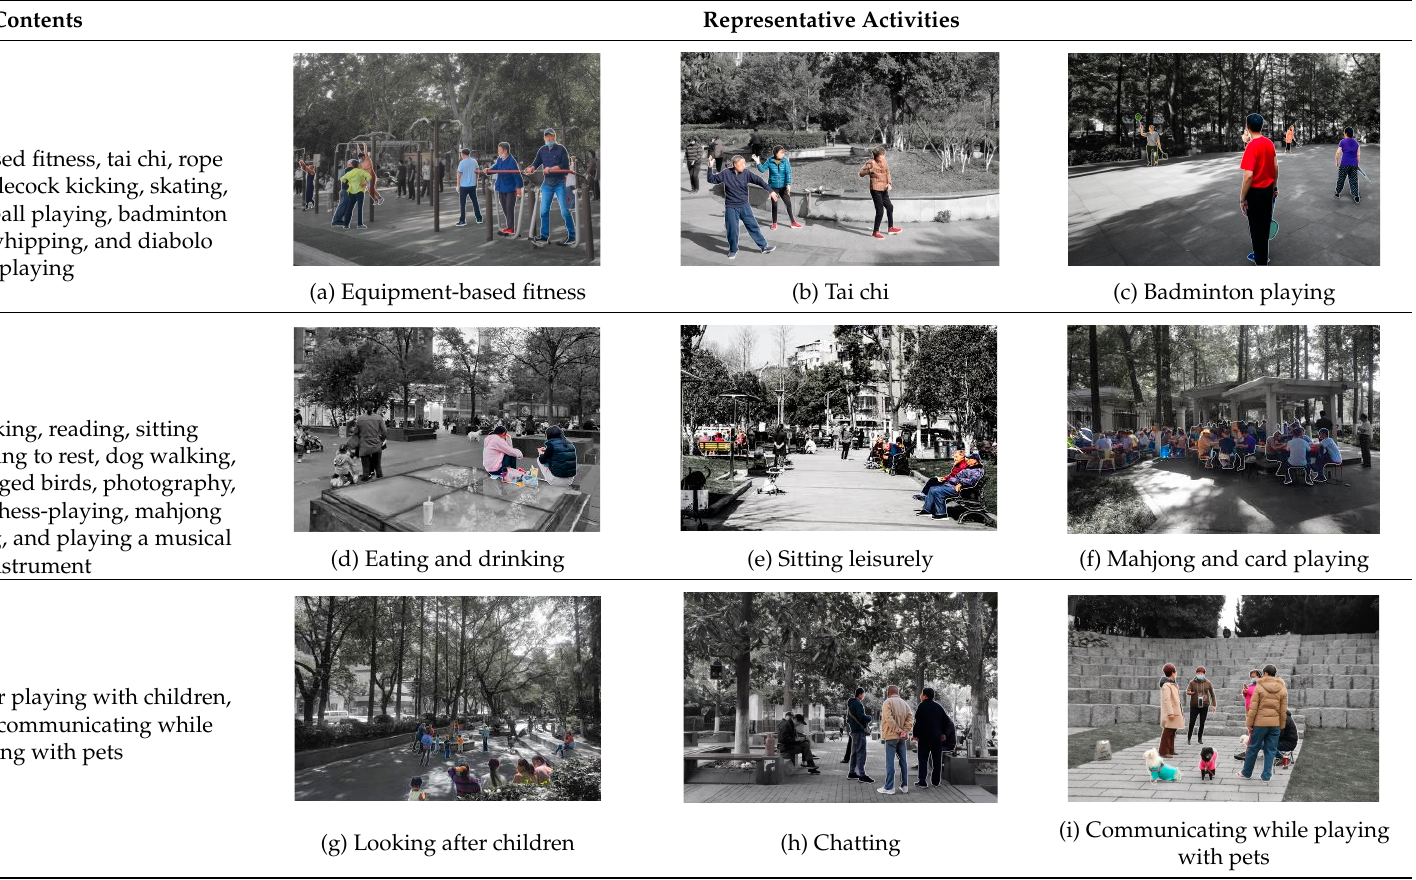
Table 1. Classification framework of recreational activities within pocket parks.